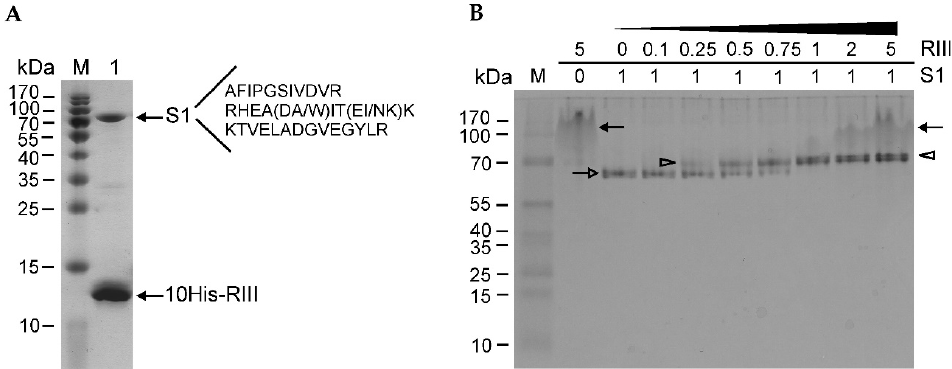
Figure 1. Determination of protein–protein interactions using protein electrophoresis. ( A ) The SDS-PAGE (14%) analysis of the purified N-terminally His-tagged recombinant RIII protein of bacteriophage T4. The amino acid sequences of the identified peptides are listed next to the identified protein. Lanes: M—PageRuler TM Prestained Protein Ladder (Thermo Fisher Scientific, Vilnius, Lithuania); 1—the sample of purified recombinant His-tagged RIII protein. Arrows indicate two co-purified proteins. ( B ) Determination of the stoichiometry of interaction between N-terminally His-tagged RIII protein and E. coli ribosomal protein S1. The protein complexes were assembled in vitro and then analyzed by a native PAGE (14%). M—PageRuler™ Prestained Protein Ladder. Numbers above the lanes indicate the molar ratios between RIII and S1. Black arrows show the aggregates of RIII, the open arrow points to the S1 protein, and open arrowheads mark the RIII–S1